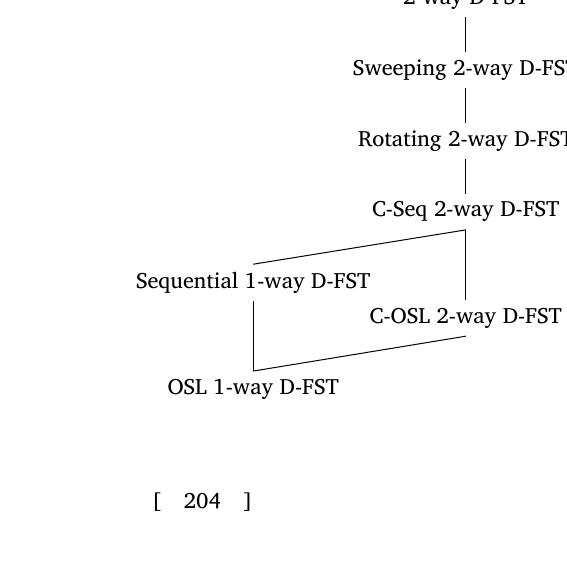
2-way D-FST Sweeping 2-way D-FST Rotating 2-way D-FST